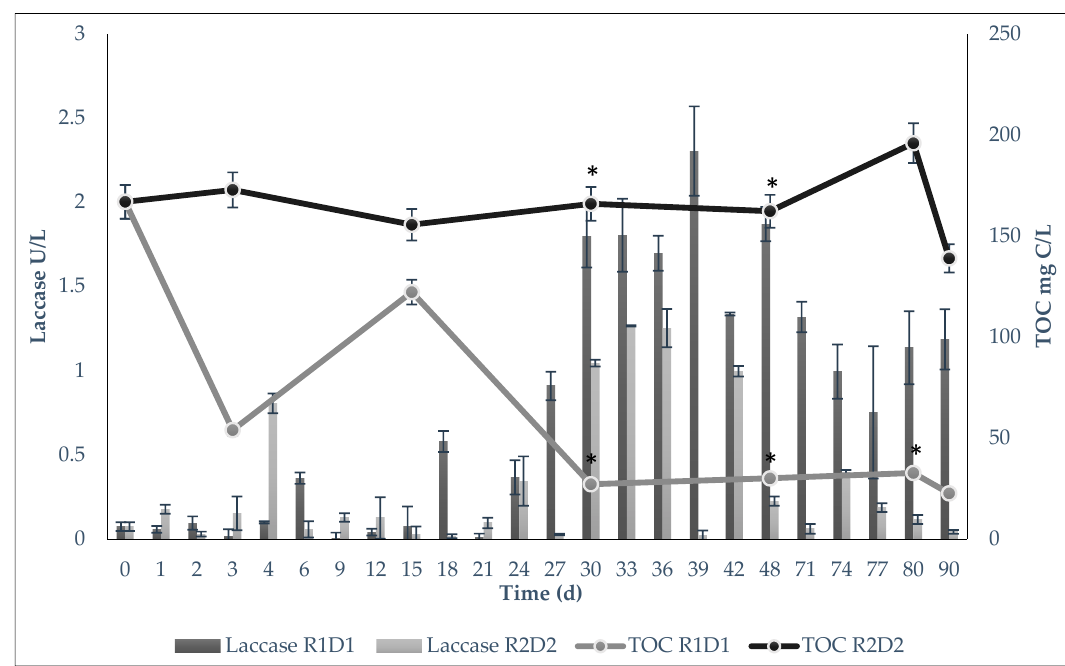
Figure 3. Laccase activity and TOC trend in Cuoio Depur intermediate LFL treating bioreactors using Lambertella sp. immobilized on PUFs. R1D1 myco-augmented bioreactor, R2D2 not inoculated bioreactor (Control). Values represent mean values of the level of laccase and TOC from three biological replicates for time of analysis. Bars represent the standard deviation (SD) among the three replicates of analysis. All the values are significantly different from the corresponding value at the previous time of analysis at a 1% level (p < 0.01), with the exception of the values with asterisk (*), which are statistically not different.